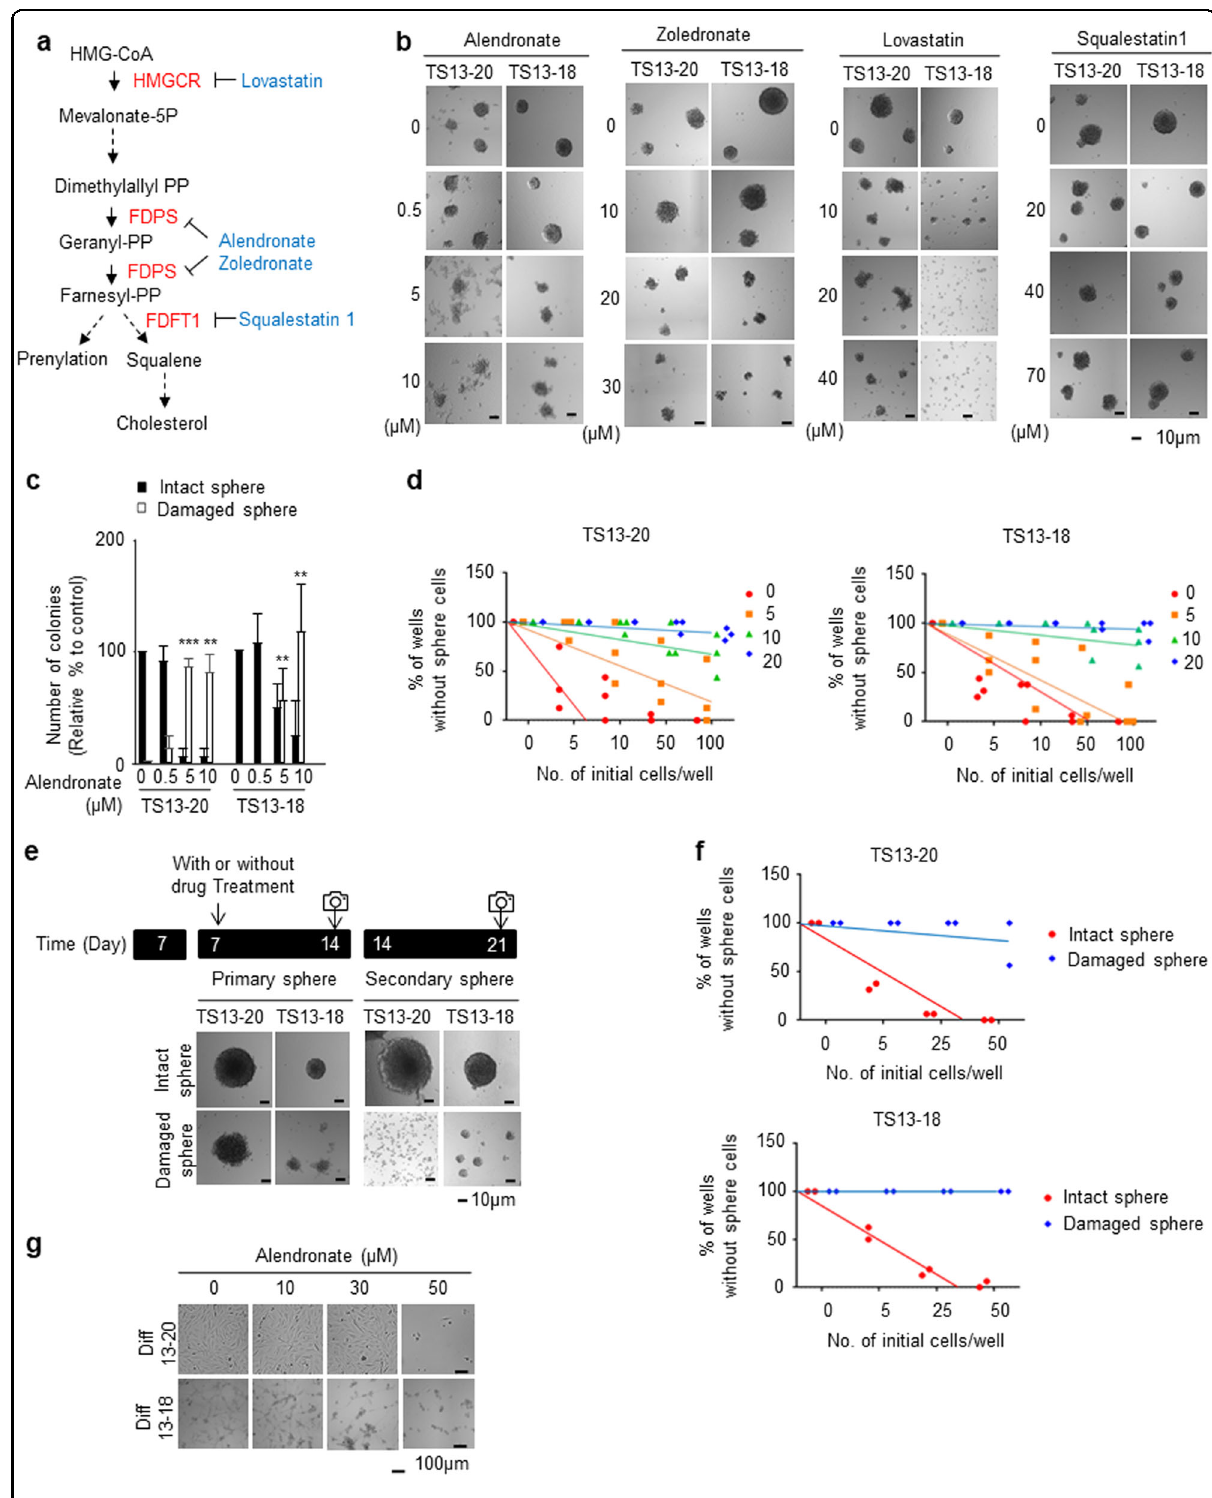
Fig. 3 (See legend on next